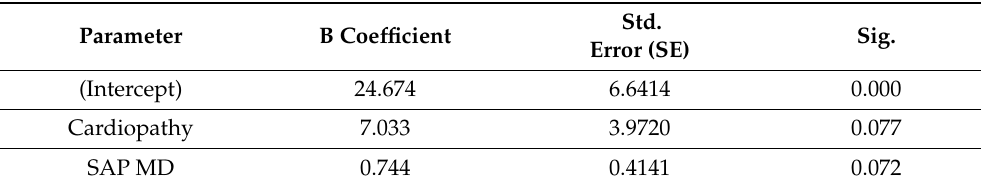
Table 4. Regression model for time of duration of the therapy in the overall cohort. The variables were selected through a stepwise forward selection